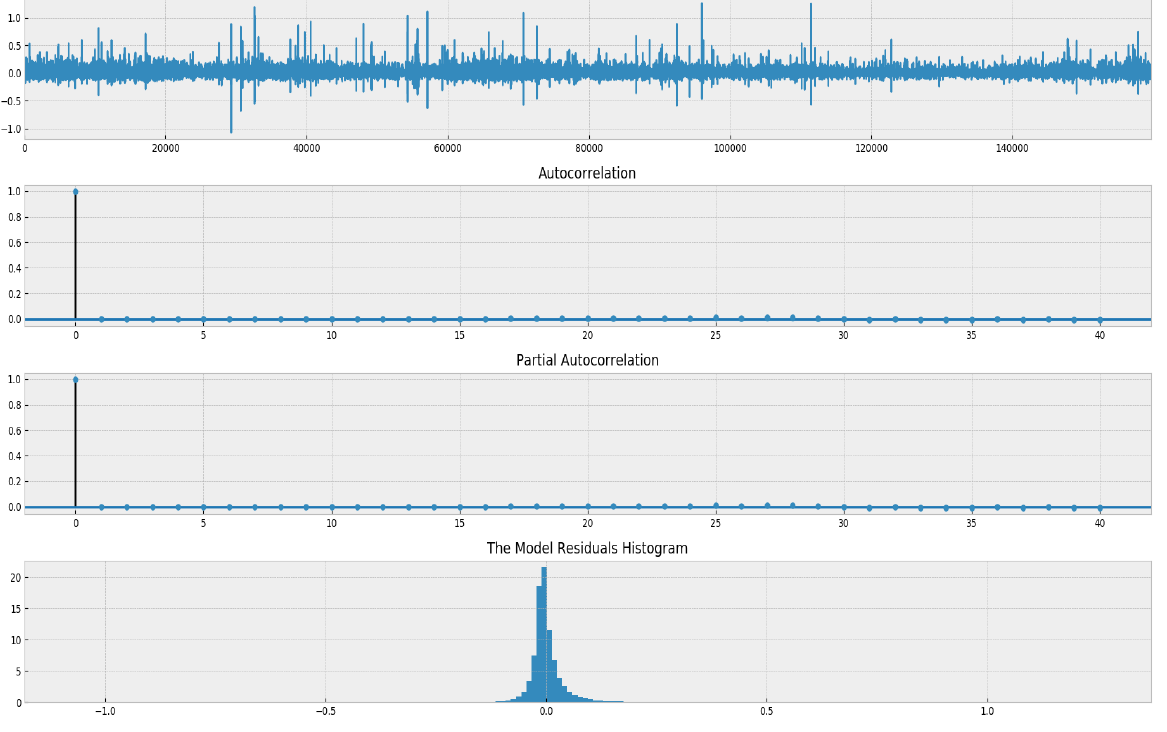
Figure 2: Model Residuals: ACF/PACF-plot and Histogram-plot of EIA Weekly Distillates Stocks on WTI Crude Oil. 1-hour window rolling standard deviation from (Jan. 2012 - Dec.